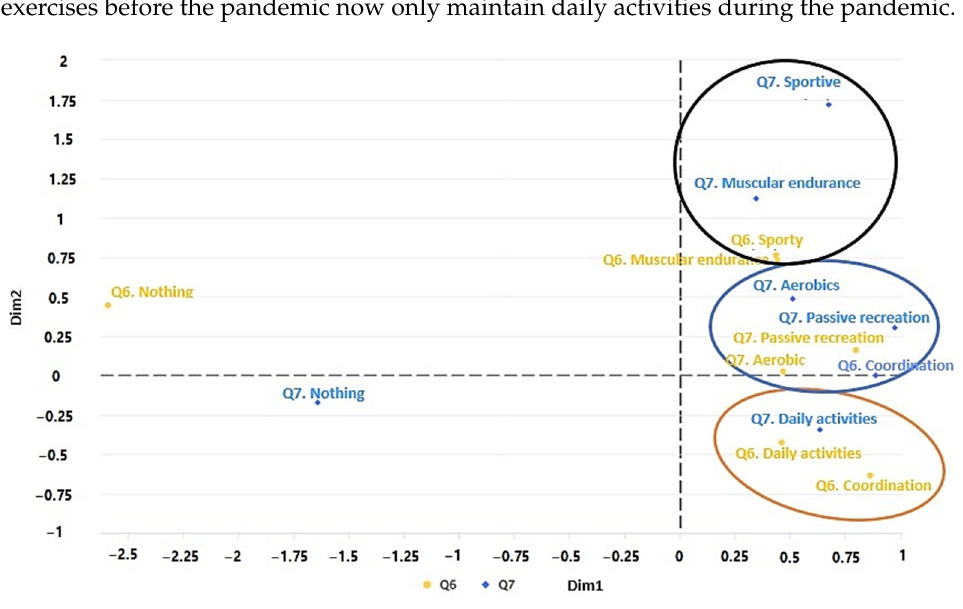
Figure 9. Multiple factor analysis (MFA) of the variables of faculty, Q6, Q7.